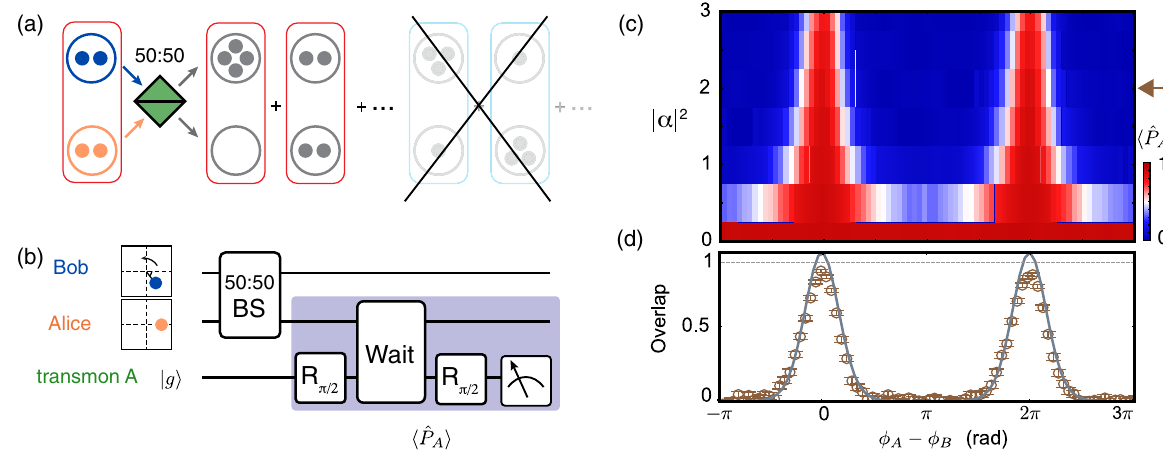
FIG. 4. Measurement of quantum state overlap. (a) When two identical bosonic systems interfere at a 50 ∶ 50 BS, only even photon- number outcomes are allowed due to the full destructive interference of the odd distributions. This allows us to infer the state overlap ρ Þ from photon-number parity measurement of one of the output ports. (b) The experimental protocol for implementing the Tr ð ρ A B overlap measurement between Alice and Bob. (c) Measurement of overlap between j ψ i − ϕ Þ and amplitude α . Maximum overlap for each displacement is measured when ϕ the relative displacement angle ð ϕ A B 2 π ). (d) 1D cut at displacement of j α j 2 ≈ 2 . Data are shown in brown circles, which shows good agreement with the overlap determined by full Wigner tomography of each mode, shown in solid gray line. The dashed gray line indicates the predicated peak contrast after taking into account self-Kerr and the decoherence of the